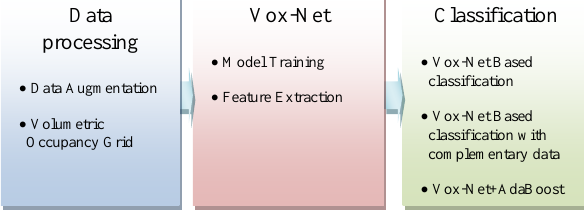
Figure 1. The conceptual framework of the Vox-Net based feature extraction and